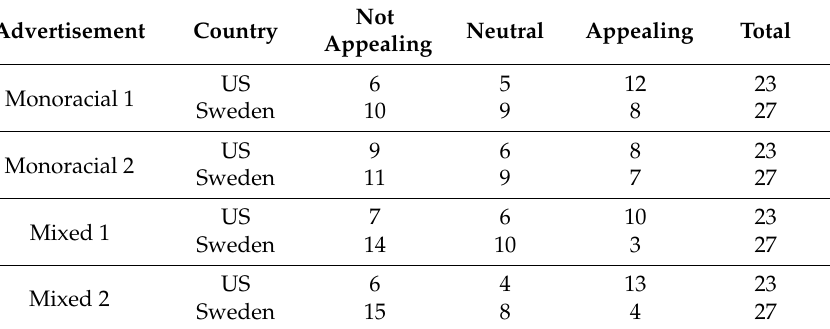
Table 1. Preference of advertisements.